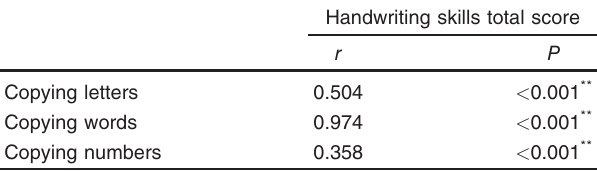
Table 5 Correlation between handwriting skills total and its subtotal score